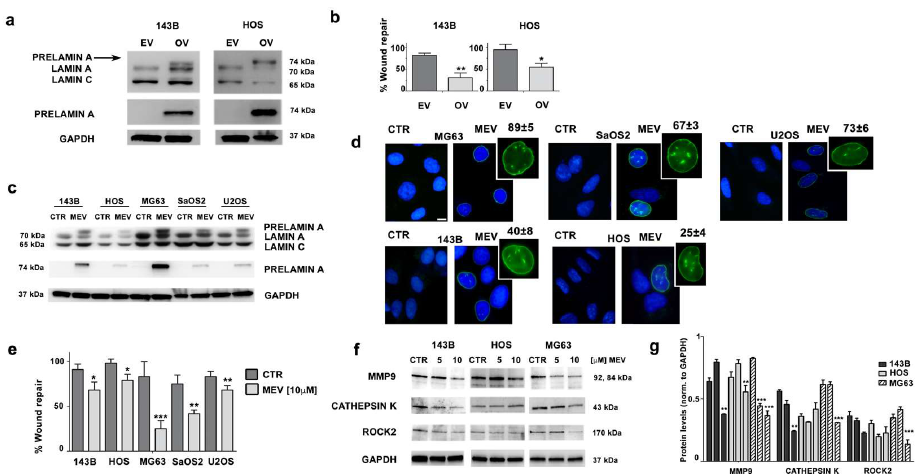
Figure 4. ( a ) Western blotting analysis of 143B and HOS cells overexpressing prelamin A. EV, cells transfected with empty vector; OV, cells overexpressing unprocessable prelamin A (LA-C661M). Prelamin A expression was assessed using a lamin A/C antibody which detects lamin A, lamin C and prelamin A. An anti-prelamin A antibody, which recognizes only prelamin A, was also employed. ( b ) Wound healing assay performed in 143B and HOS cells overexpressing prelamin A. Results are the mean ± SD of three independent experiments. Asterisks indicate statistically significant differences versus empty vector cells (EV), * p < 0.05, ** p < 0.01. ( c ) Western blotting analysis of OS cell lines treated